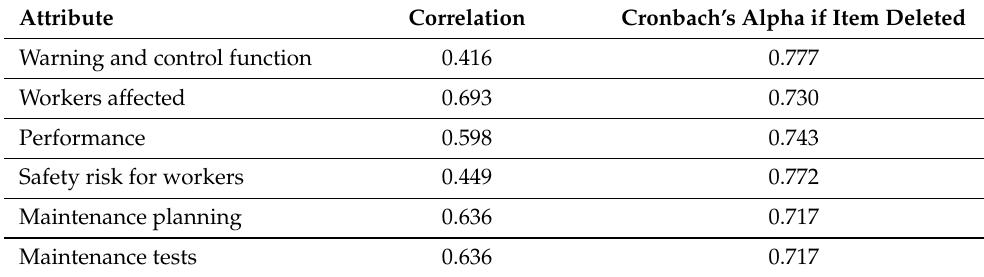
Table 7. Cronbach’s Alpha test